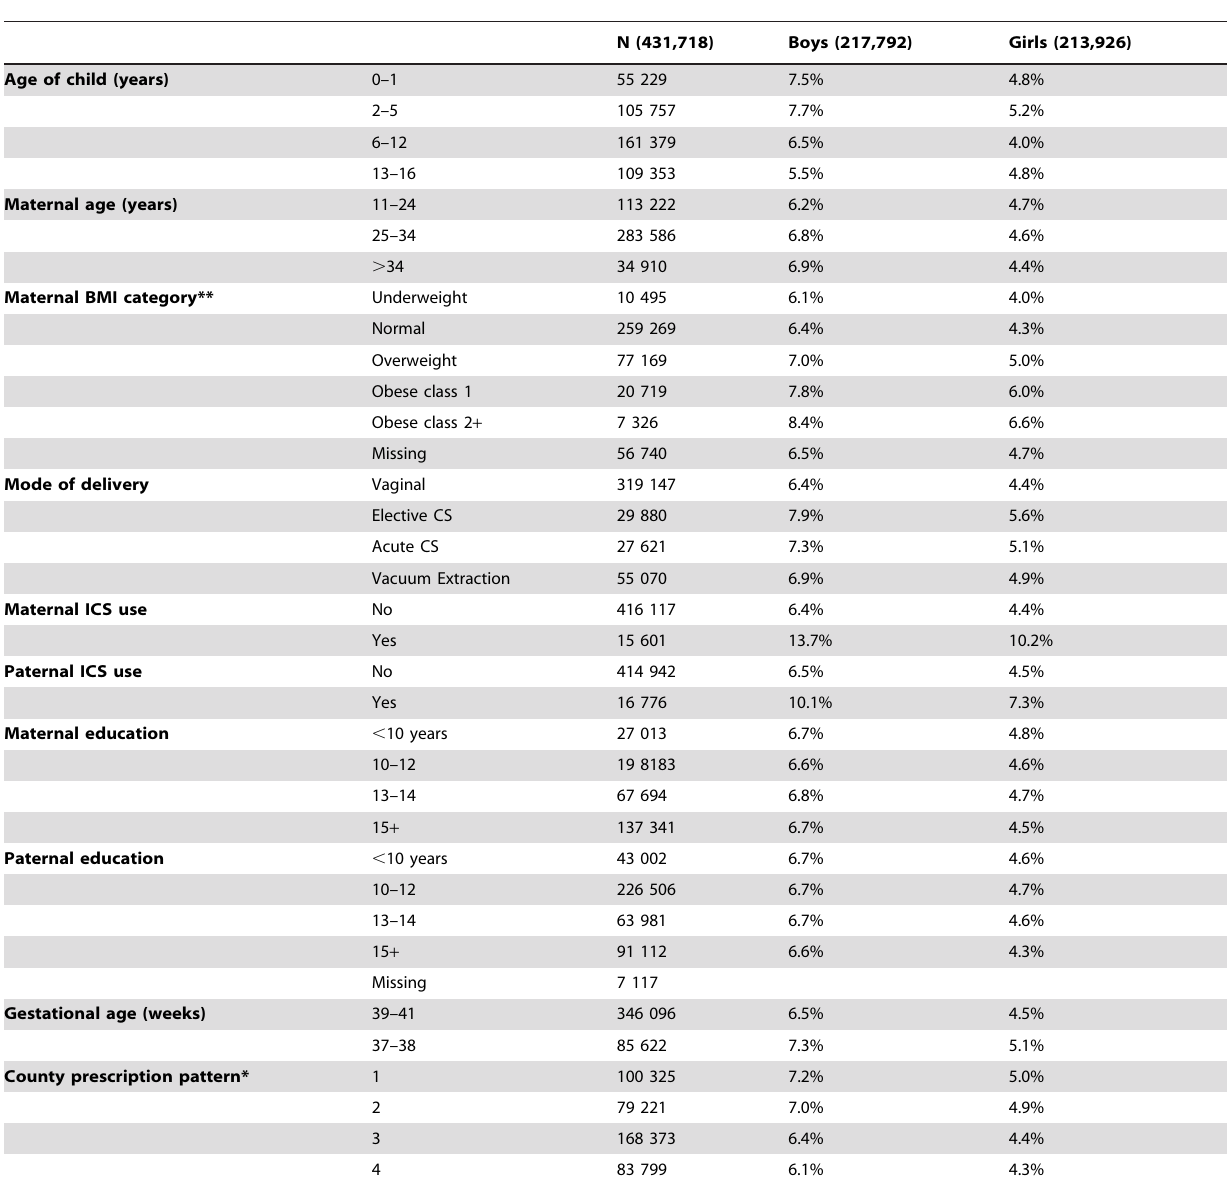
Table 1. Prevalence of ICS use in first borns by selected socio-demographic factors, delivery details, and markers of parental